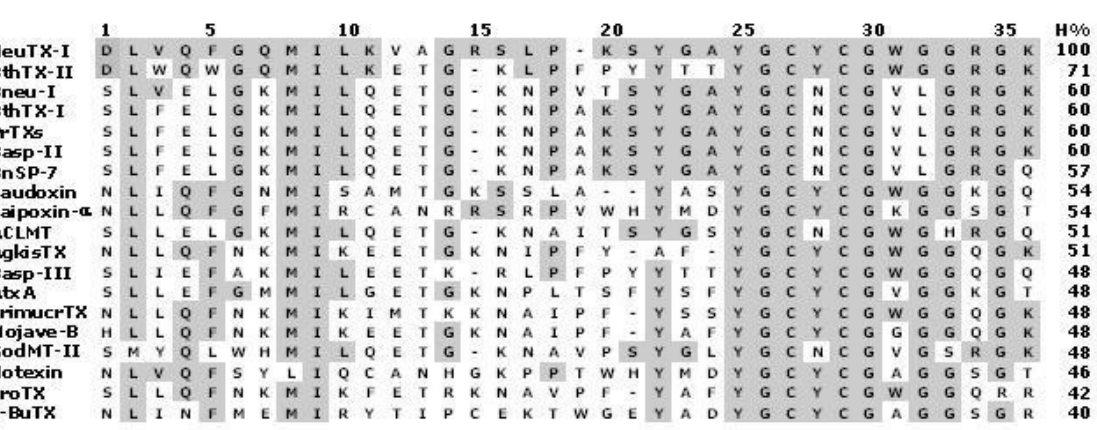
Figure 3. Amino acid sequence alignment of NeuTX-I with myotoxic and presynaptic neurotoxic PLA 2 toxins. Bothropstoxin-II (BthTX-II), from B. jararacussu (36); Bneu-I, from B. neuwiedi (15); bothropstoxin-I (BthTX-I), from B. jararacussu venom (8); piratoxins (PrTXs), from B. pirajai venom (48); Basp-II, from Bothrops asper venom (14); BnSP7, from B. neuwiedi (46); caudoxin, a presynaptic neurotoxin from Bitis caudalis (52); taipoxin- α , a presynaptic neurotoxin from Oxyuranus s. scutellatus (31); ACLMT, a myotoxin from Agkistrodon contortrix laticinctus (22); agkistrodotoxin (AgkisTX), a presynaptic neurotoxin from Agkistrodon halys pallas (28); Basp-III, from Bothrops asper venom (23); ammodytoxin A (AtxA), from Vipera ammodytes ammodytes (42); trimucrotoxin (TrimucrTX), from Trimeresurus mucrosquamatus (49); basic component of mojavetoxin (Mojave-B), from Crotalus , from Cerrophidion (Bothrops) godmani (11); scutulatus scutulatus (2); GodMT-II, myotoxic PLA 2 notexin, from Notechis scutatus scutatus (17); basic component of crotoxin (CroTX), from Crotalus durissus terrificus (1); β -bungarotoxin ( β -buTX), from Bungarus multicinctus (26, 27). Conserved residues are in gray. The percentage homology (H%) is also shown.